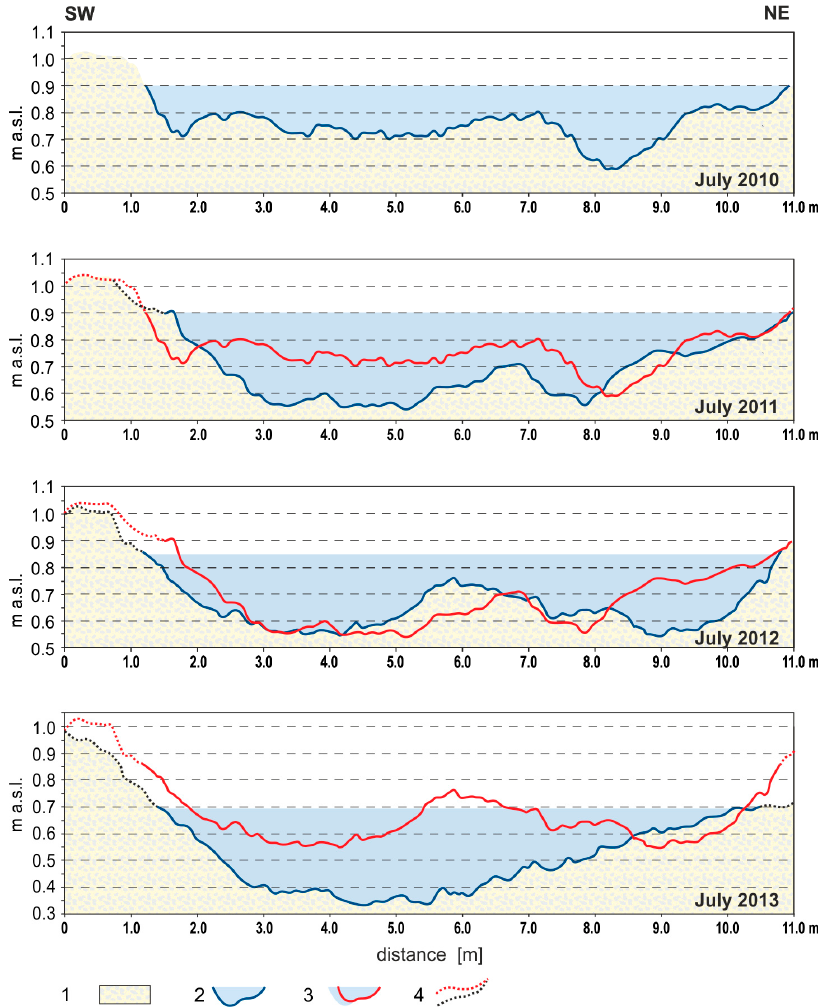
Figure 4. Changes in the channel bottom in XS II between 2009 and 2013: 1. Bedrock, 2. Current stage, 3. Previous stage (last season), 4. Dry streambank. Table 2. Inter-annual variability of channel processes and intensity of streambank erosion in the Scott River channel.